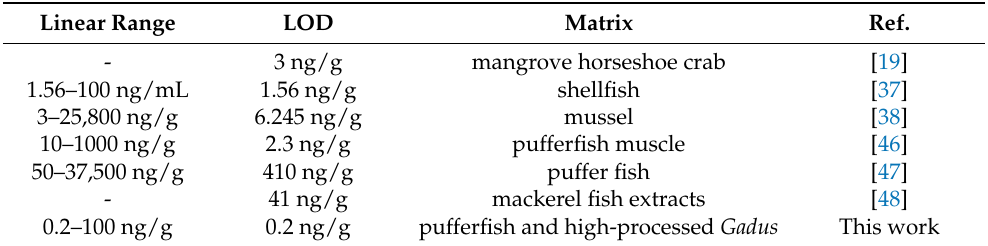
Table 3. Comparison of the TTX determination based on the proposed method with the previously reported literature using HPLC-MS/MS method. LOD Matrix Ref.